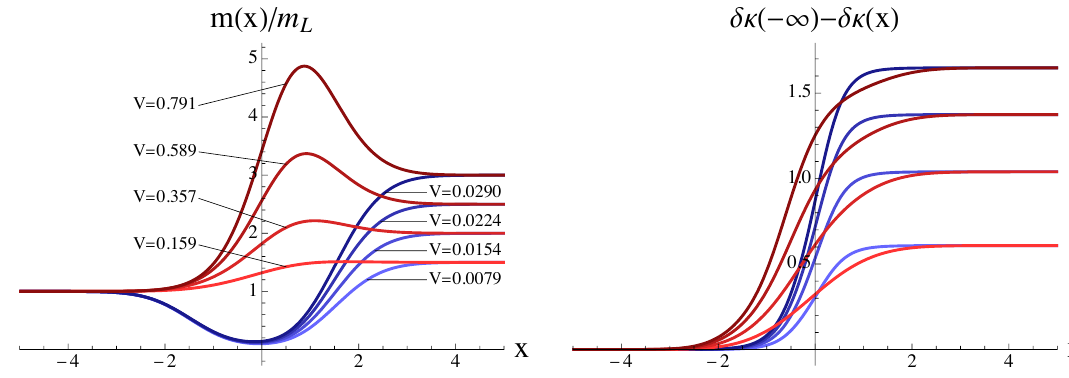
Figure 9 . Flowing funnels for α = 2 . 5 . Two distinct branches are plotted by red and blue